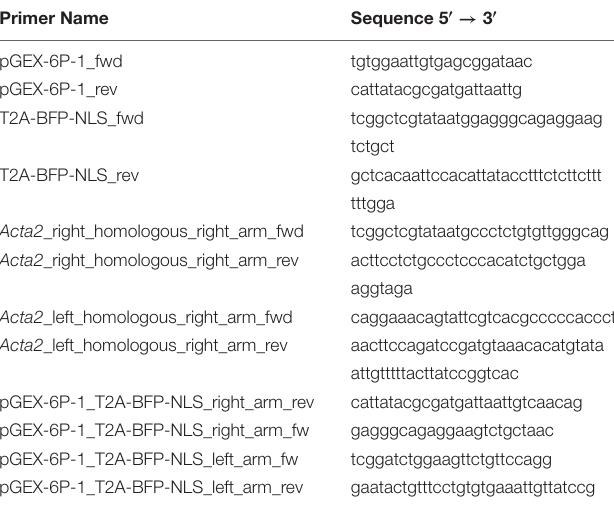
TABLE 1 | Primers used for cloning of T2A-BFP-NLS and homology arms into donor vector pGEX-6P-1. Primer